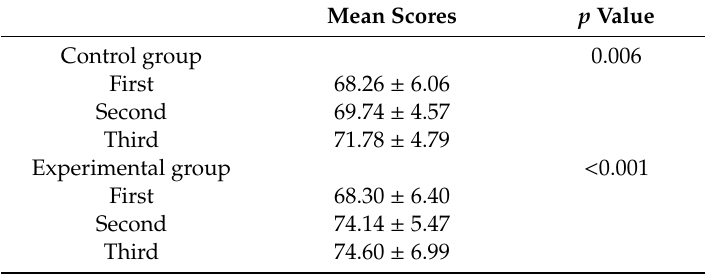
Table 1. Mock Objective Structured Clinical Examination (OSCE) mean scores of the control group and the experimental